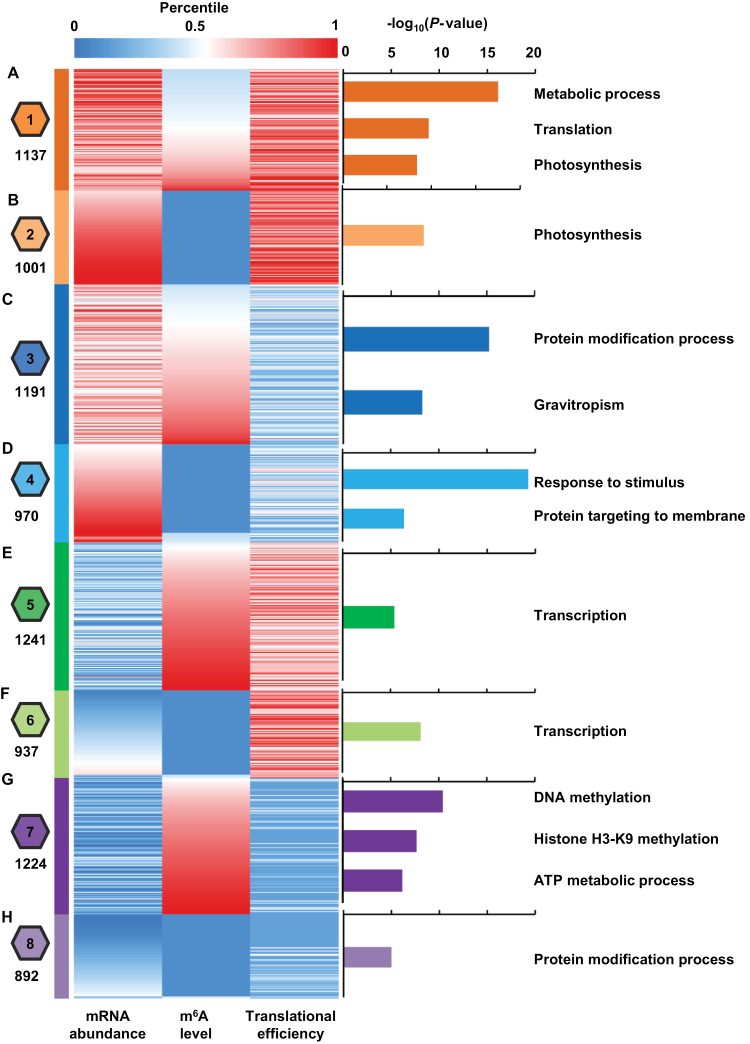
Distinct enrichment of biological pathways coordinated at the levels of mRNA abundance, m6A modification, and translational efficiency in the hybrid. (A–H) Non-additive genes characterized by mRNA abundance, m6A modification, and translational efficiency were compiled together and subject to k-means clustering analysis. Each level of mRNA abundance, m6A intensity, and translational efficiency was converted to percentiles using the empirical cumulative distribution function. The color indicates the relative level of mRNA abundance, m6A intensity, and translational efficiency. A total of eight clusters were identified and the number of genes in each cluster is shown at the left. Significantly enriched gene ontology (GO) terms were identified by FuncAssociate 3.0 (permutation-based corrected P<0.001) and shown at the right. The details of all significantly enriched GO terms are listed in Supplementary Table S6.